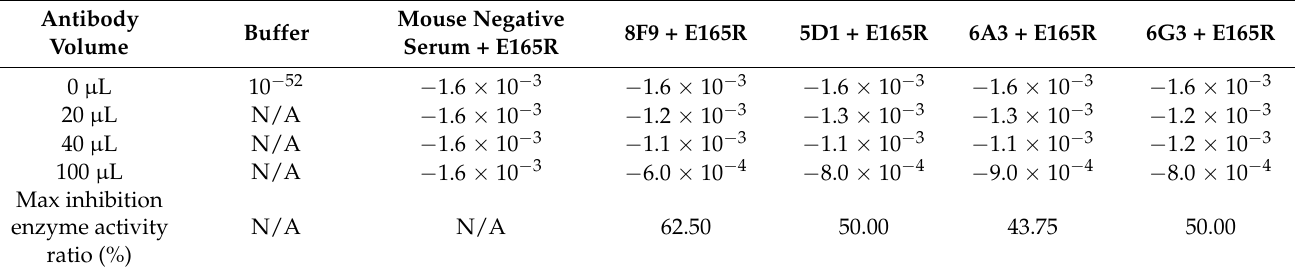
Table 2. Effects of mAbs on the enzyme activity of recombinant E165R.